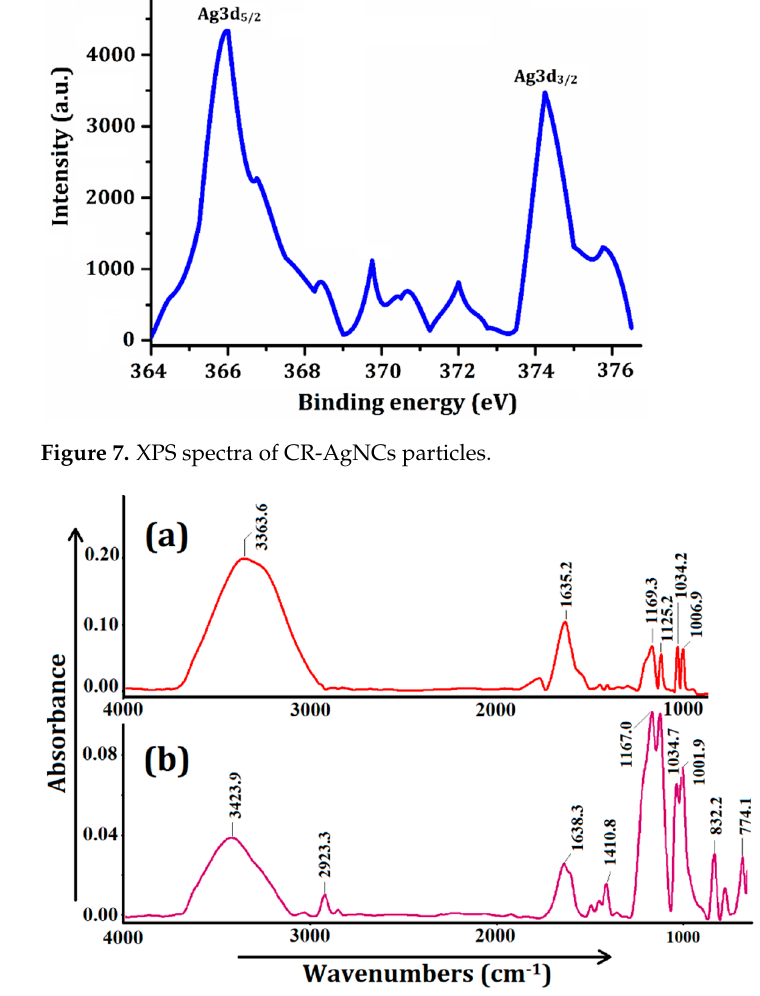
Figure 7. XPS spectra of CR-AgNCs particles.